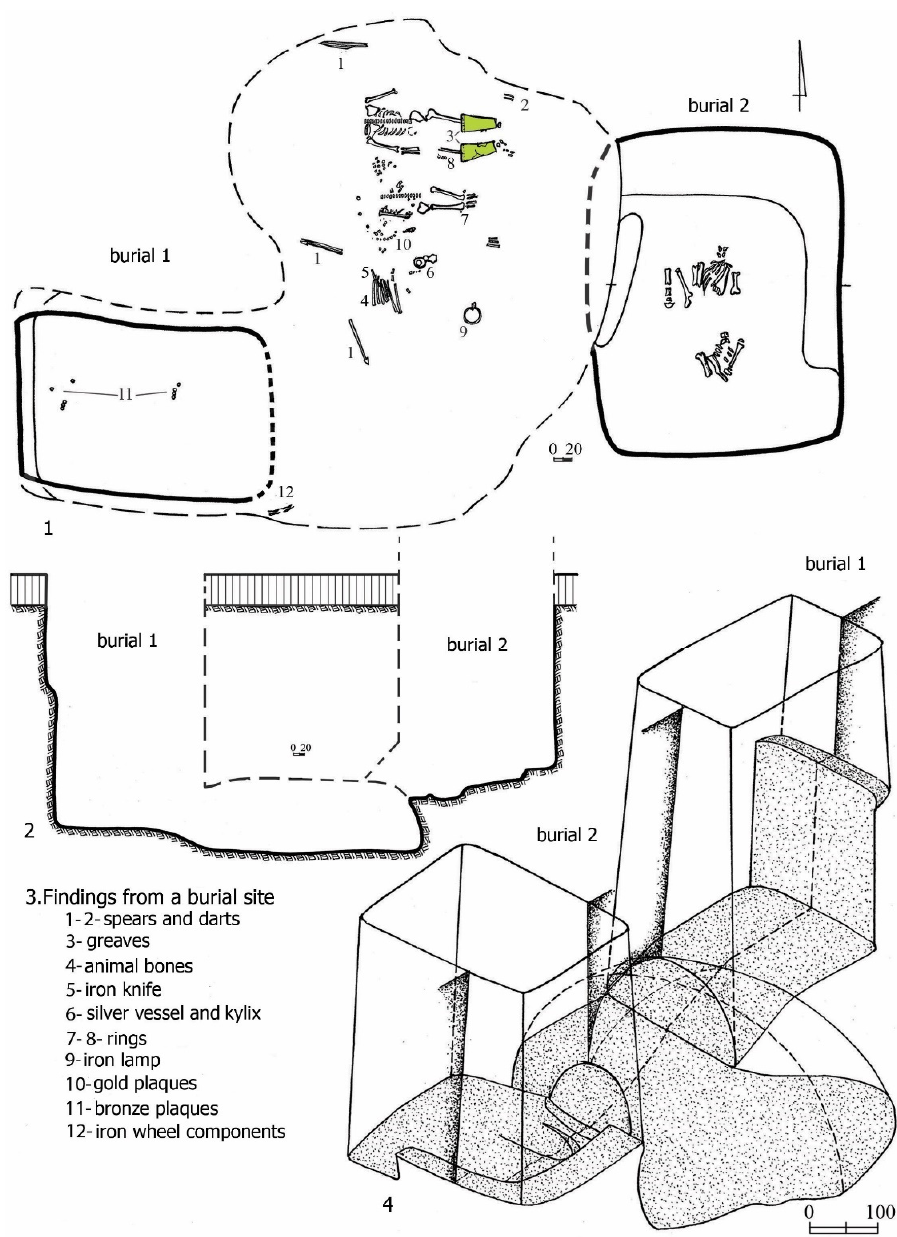
Figure 1. Vodoslavka Barrow 6 Burials 1–2. (1)—General plan of the Burials 1–2; (2)—General section of the catacomb burial ground 1–2; (3)—Findings from a burial site; (4)—Axonometric view of the Burials 1–2 (reconstruction Т .